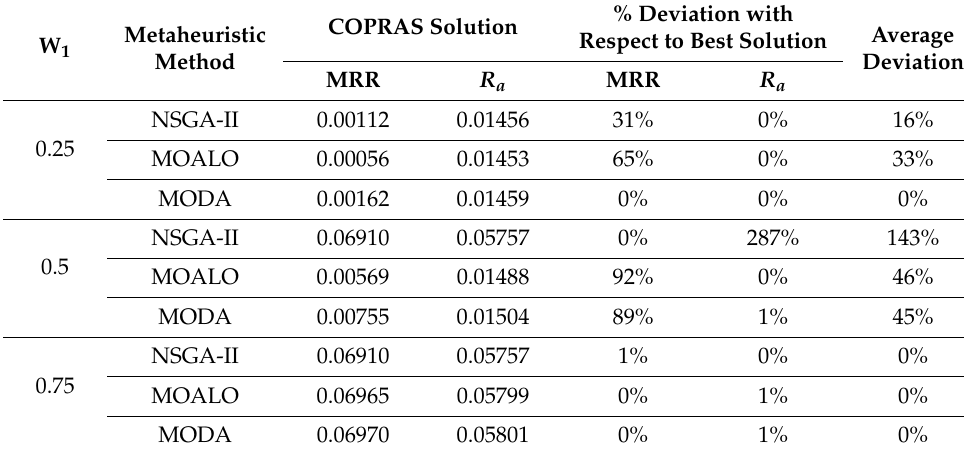
Table 5. Deviation in solutions of different metaheuristics as compared to the best solution by considering W 1 = 0.25, 0.5 and 0.75 for COPRAS